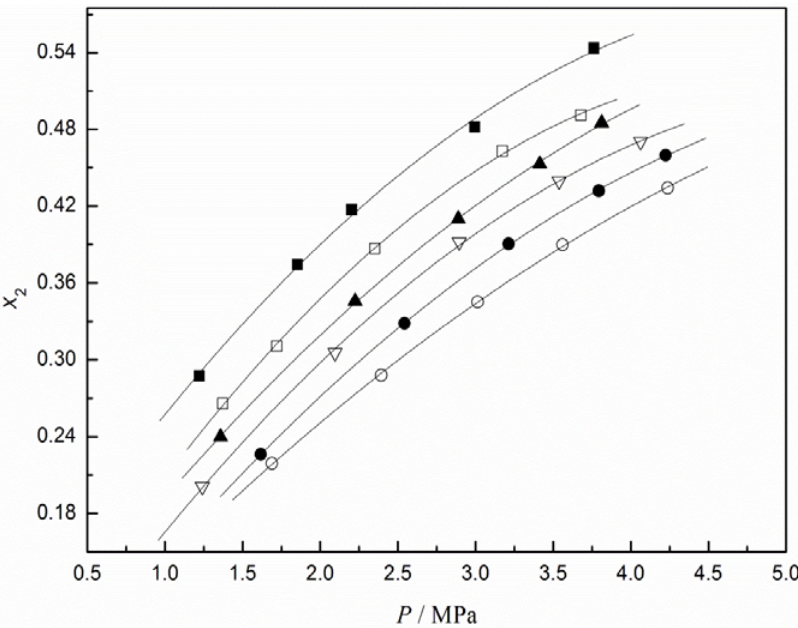
different temperatures: ( ■ , 293.13 K; □ , 303.15 K; ▲ , 313.15 K; ▽ , 323.15 K; ● , 313.15